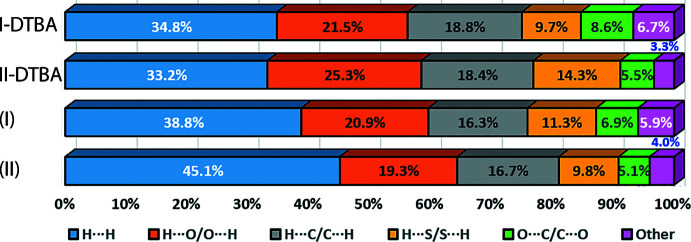
A comparison of the percentage contributions of various contacts to the Hirshfeld surfaces for (a) DTBA in (I), (b) DTBA in (II), (c) (I) and (d) (II).